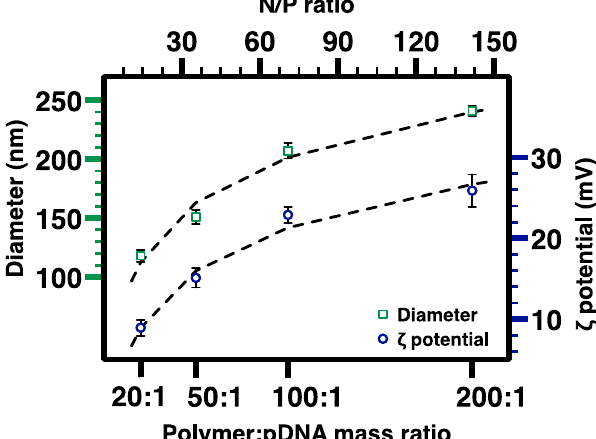
Figure 10. DLS measurement of number-average hydrodynamic diameter ( D h,N ) and zeta potential ( ζ ) of nanocomplexes at various PEG- b -CPCL-70:pDNA mass and N / P ratios. The error bars represent the standard deviation from 3 independent measurements.